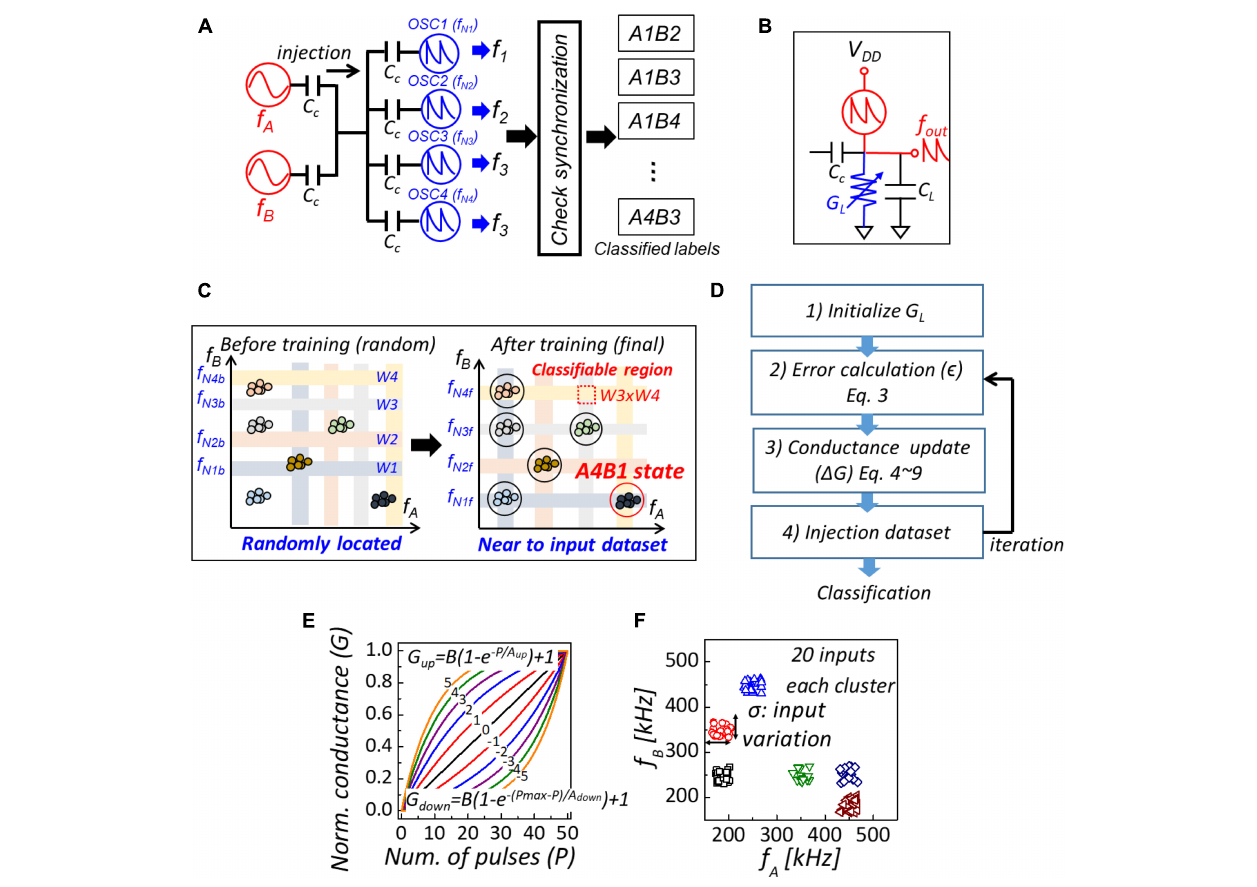
FIGURE 2 | (A) Four-coupled oscillators configuration of a clustered data classification using (B) NbO 2 -based oscillator with analog memory device. (C) Synchronization map of before and after training. W is synchronization window and classifiable region is overlapped area with synchronization windows (W × W). (D) Flow chart of conductance update for classification of clustered data. (E) Normalized conductance response to applied number of pulses. (F) Training and test dataset with input